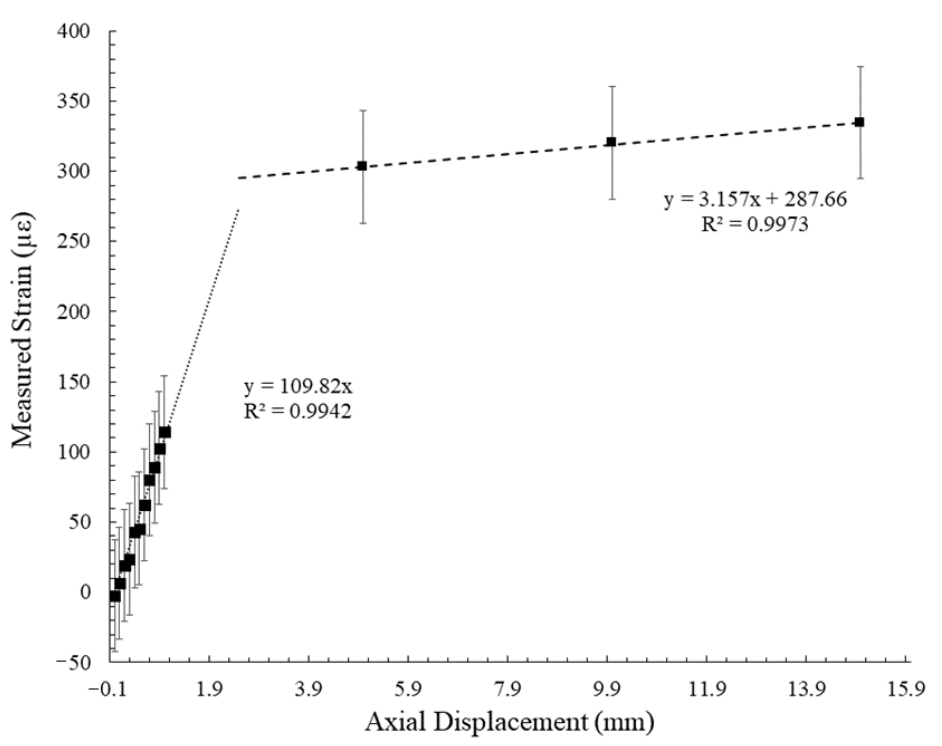
Figure 22. Measured strain values for tensile deformation experiments using the hybrid fiber optic cable. Note the bi-linear relationship between measured strain and displacement in high displace- ment environments.